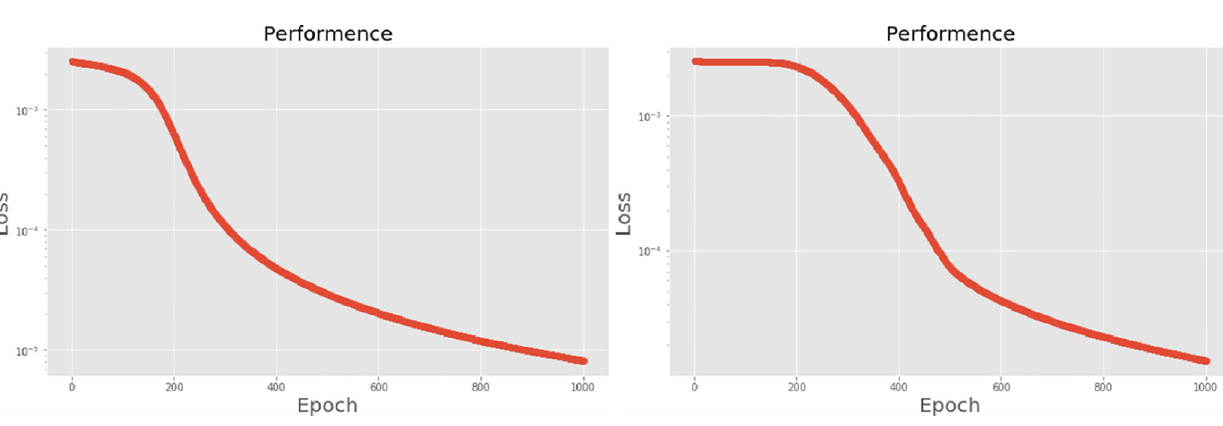
PLOS ONE | https://doi.org/10.1371/journal.pone.0259140 December23,